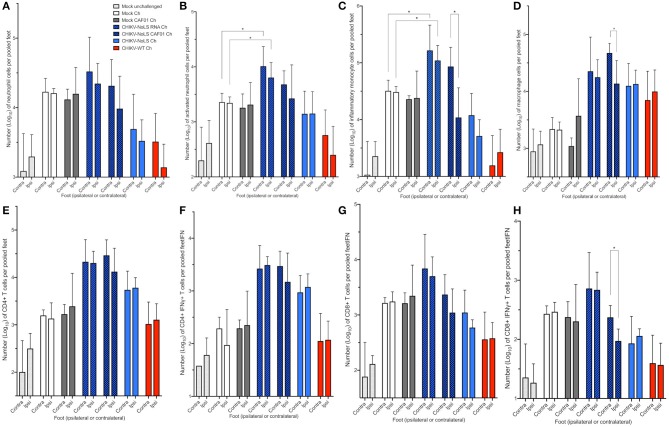
Cellular infiltration in challenged C57BL/6 mice. C57BL/6 mice were inoculated with viable virus particles (104 pfu CHIKV-WT or CHIKV-NoLS), CAF01 delivered RNA (2 μg CHIKV-NoLS RNA complexed with 0.3 mg CAF01), or RNA alone (2 μg CHIKV-NoLS RNA) subcutaneously in the ventral/lateral side of the right foot. Mock inoculated mice received 20 μl VP-SFM media alone or VP-SFM media containing 0.3 mg CAF01. At 30 days post inoculation, all groups except Mock unchallenged mice were challenged (Ch) with 104 pfu CHIKV-WT in the ventral/lateral side of the ipsilateral or contralateral foot and monitored daily for footpad swelling. Feet at 6 days post challenge were processed for flow cytometry analysis. The number of neutrophils (A), activated neutrophils (B), inflammatory monocytes (C), macrophages (D), CD4+
(E), CD4+IFNγ+
(F), CD8+
(G), and CD8+IFNγ+ T cells (H) was examined. Each symbol represents the mean ± standard error from five to six mice. Statistical analysis was performed by non-parametric Mann–Whitney t-test. *P < 0.05.